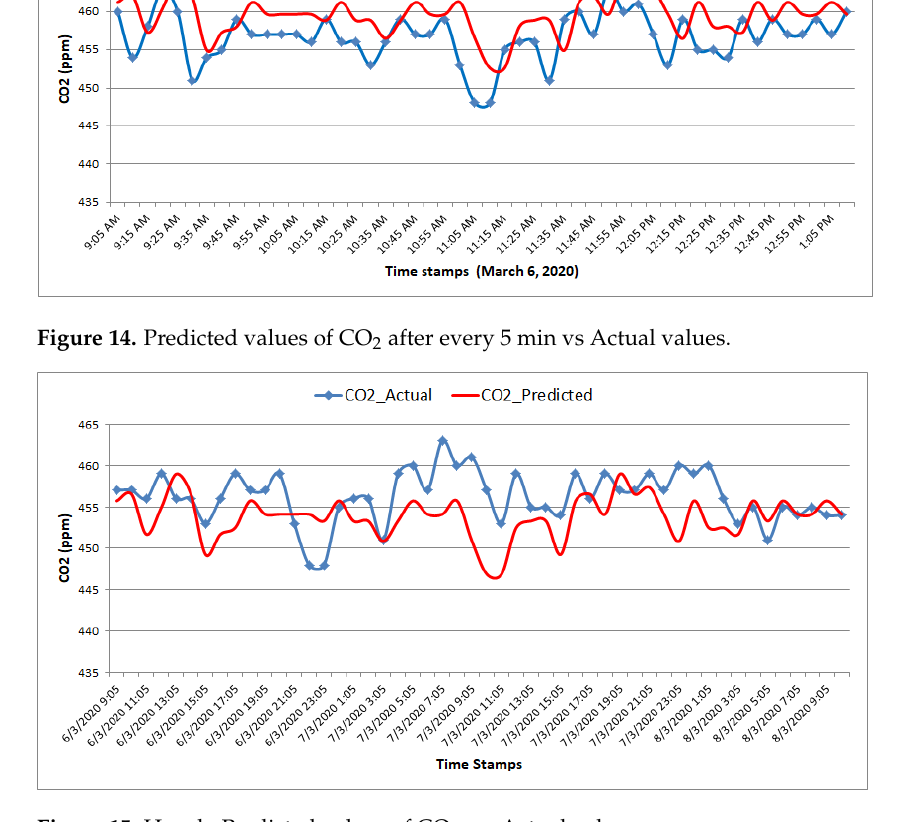
Figure 15. Hourly Predicted values of CO 2 vs. Actual